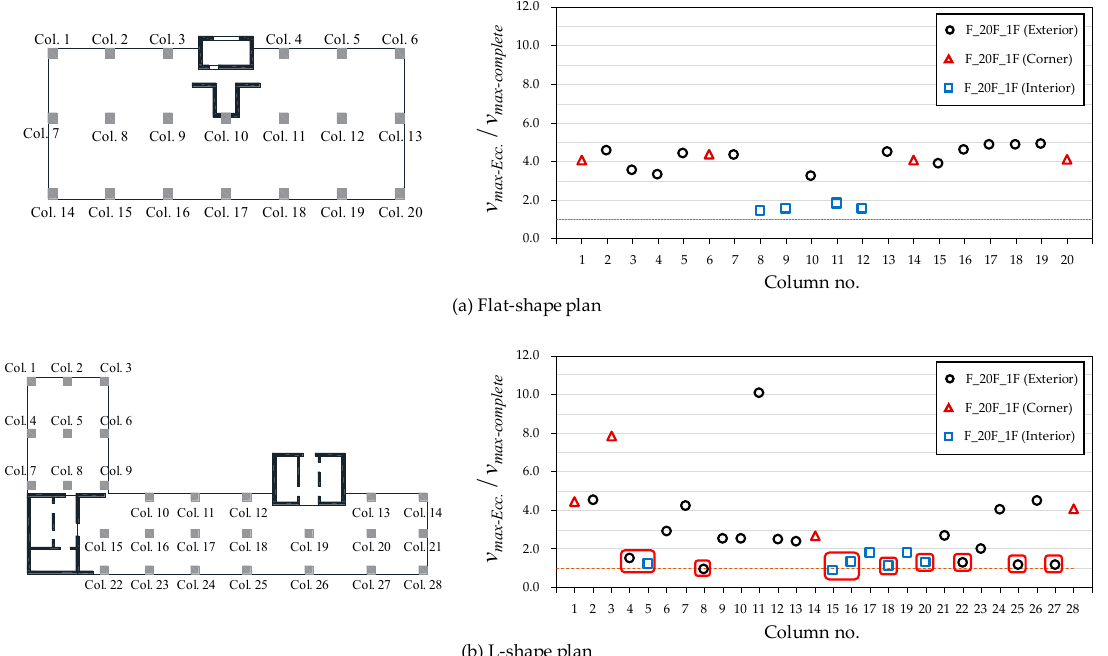
Figure 11. Maximum punching shear ratio according to the modeling method (for gravity load only). ( a ) Flat-shape plan and ( b ) L-shape